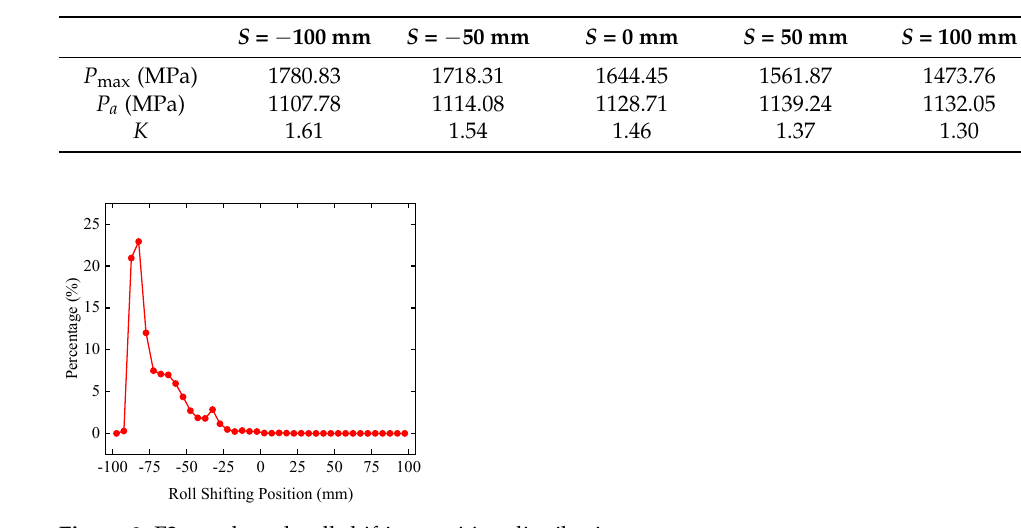
Figure 7. Contact pressure between the rolls at different roll shifting positions S ( B = 1200 mm, q = 12.5 kN/mm). Table 4. The coefficient, K , at different roll shifting positions, S .